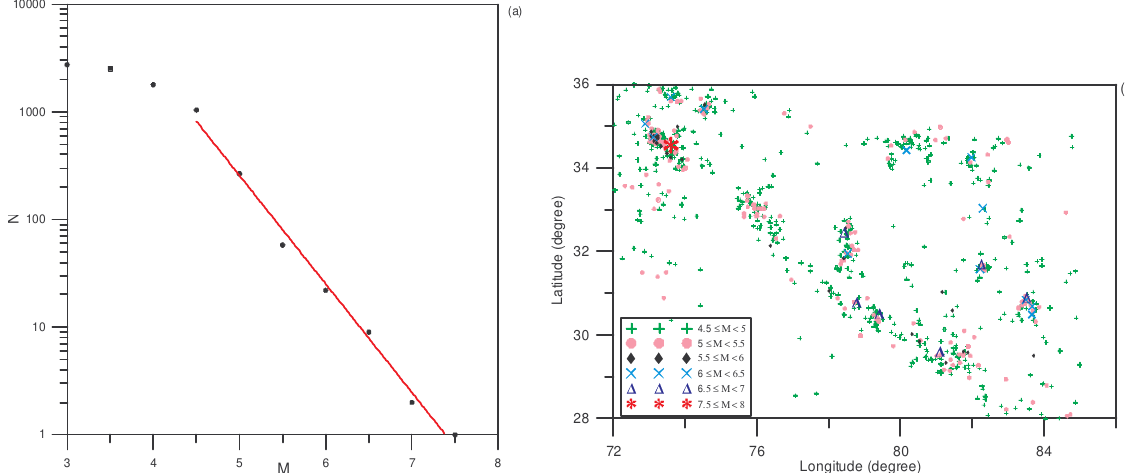
Fig. 2. (a) Frequency magnitude plot for USGS data during period from 1973 to 2009 for selected region; (b) seismicity of the selected region for m b ≥ 4 .